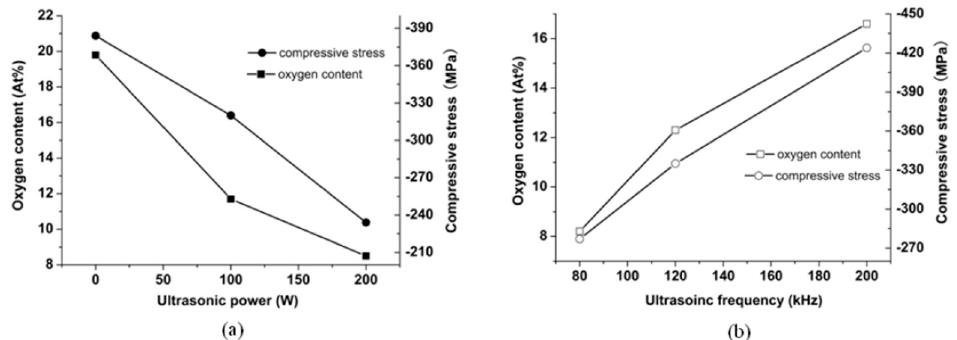
Figure 8. The influence of the ultrasonic activation on the oxygen content of the substrate surface. and the compressive stress of the electroplated Ni coating: ( a ) ultrasonic power; ( b ) ultrasonic fre-